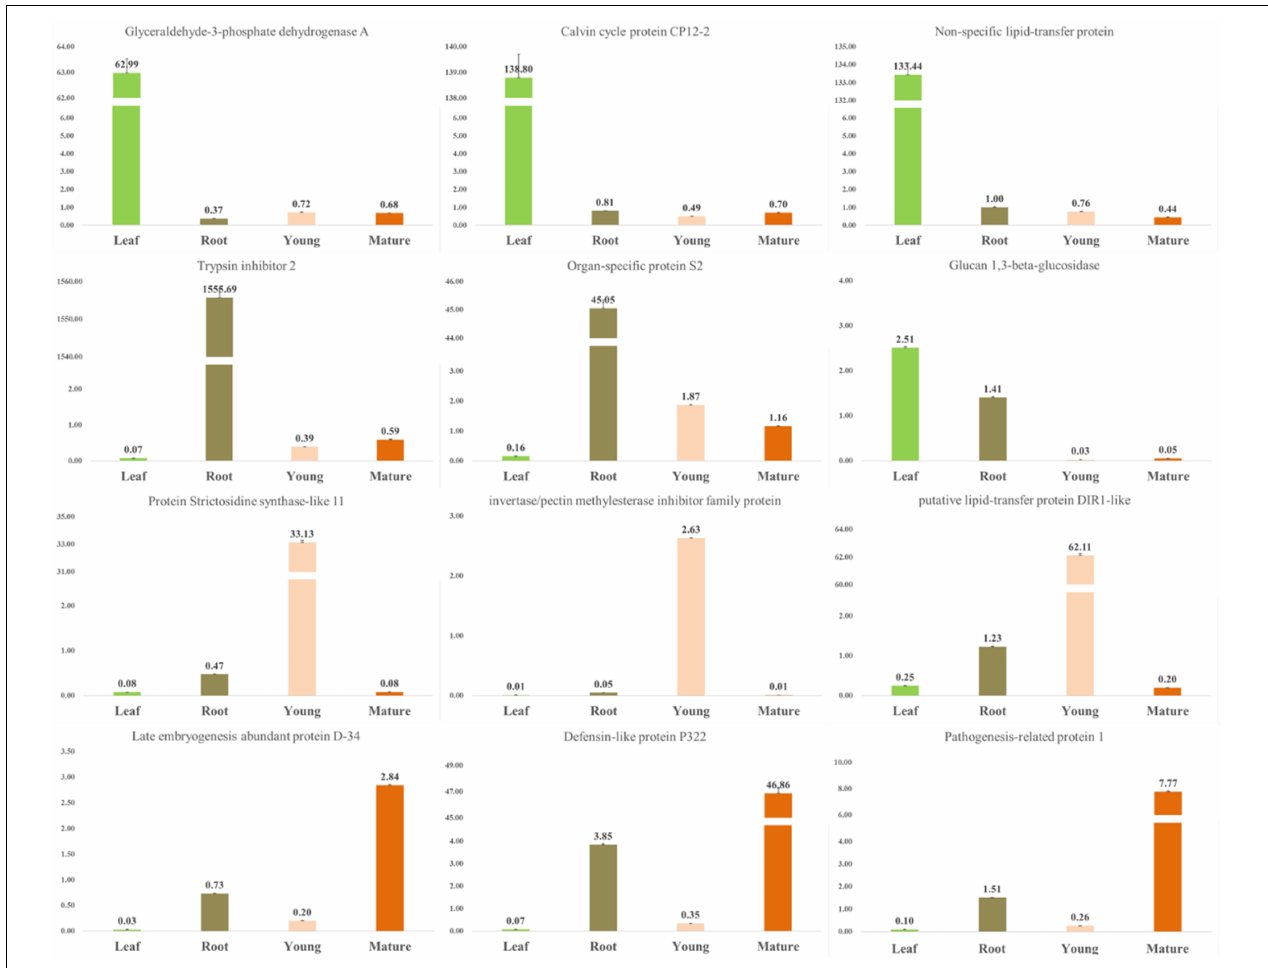
FIGURE 3 | qRT-PCR validation of tissue-specific unigene expression levels. All RT-PCR experiments were performed at least three times in each independent biological experiment (three replicates). Error bars represent the SEM.